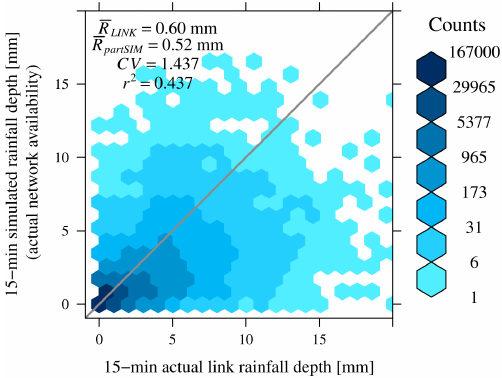
Figure 5. Scatter density plot of simulated link rainfall depths (ac- tual availability) vs. actual link rainfall depths for all 15min time steps in the 12-day validation period. Both simulated and actual link rainfall depths are path-averaged rainfall depths. The colour scale is logarithmic.